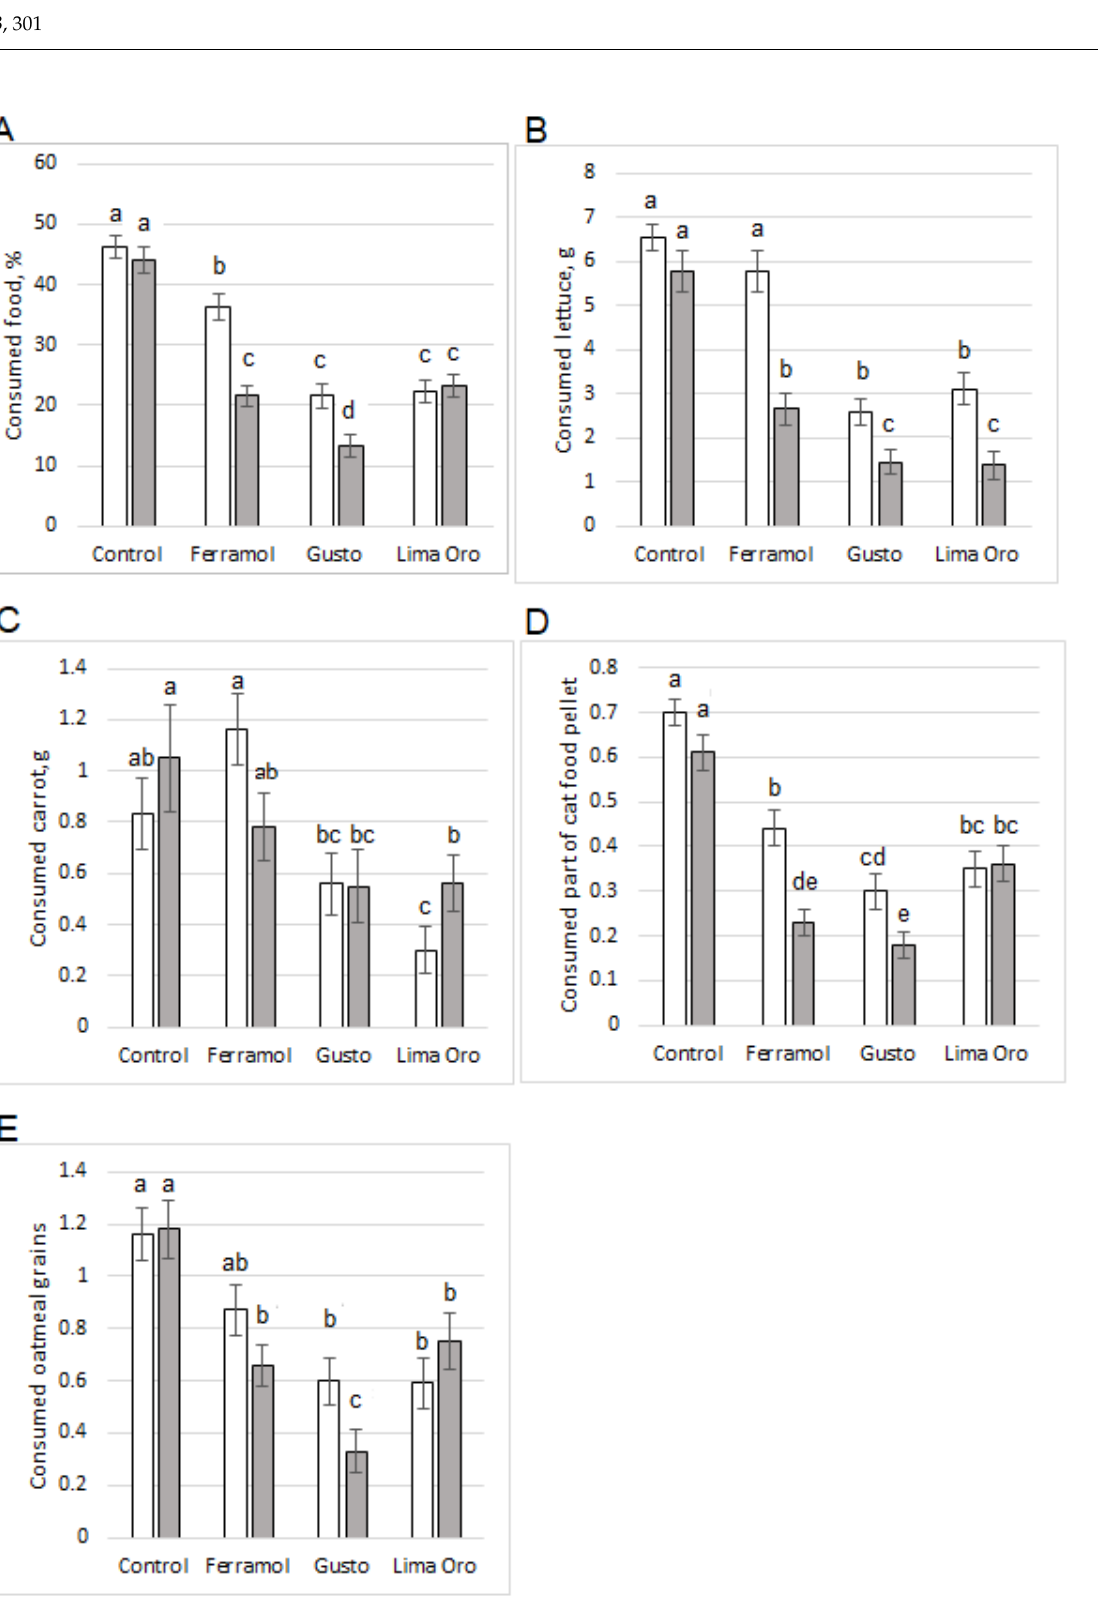
Figure 3. Mean ( ± standard error of the mean) food consumption by slugs over the seven-day experiment: ( A ) all food (mean total percentage); ( B ) lettuce (mean total g); ( C ) carrot (mean total g); ( D ) mean of total number (or part) of cat foot pellets; ( E ) mean of total number (or part) of oatmeal grains. For each bar, treatments with the same letter are not significantly different. Gray bars indicate treatments with one pellet, while black bars indicate treatments with five pellets. Means with different letters are significantly different (Tukey’s HSD, p < 0.05).